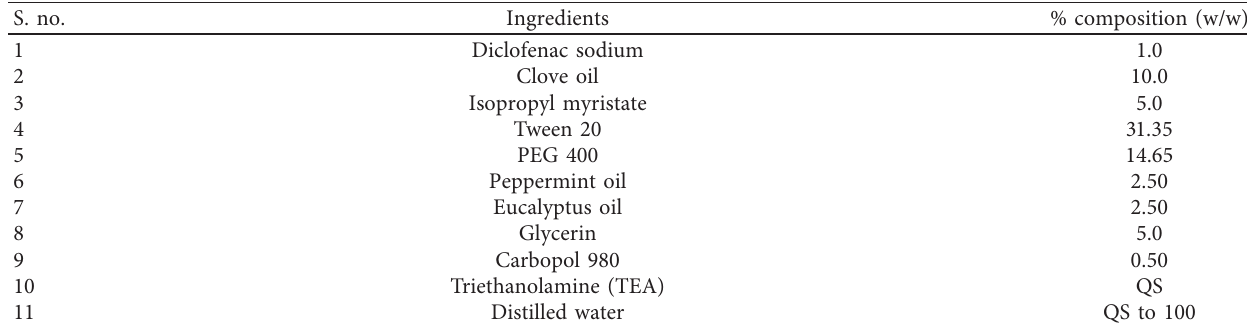
Table 2: Percentage composition of optimized